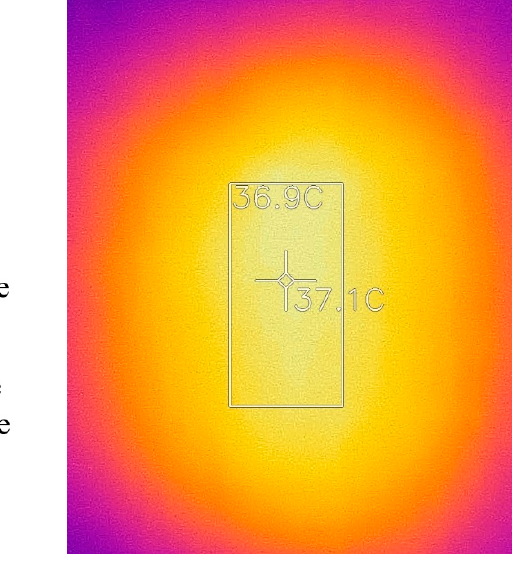
Figure 7. ( a ) Error-compensated theoretical thermal conductivity ratio for PCB-based MVAs; ( b ) variance of the heat spreading profile using error-compensated theoretical thermal conductivity ratio for PCB-based MVAs.